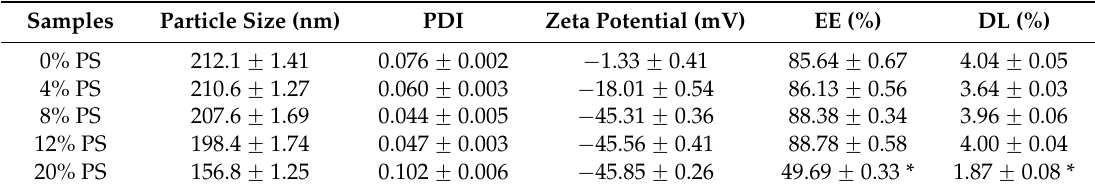
Table 1. Particle size, PDI, Zeta potential, EE and DL of different PS containing Cur-mNLCs (mean ± standard deviation (SD), n = 3).